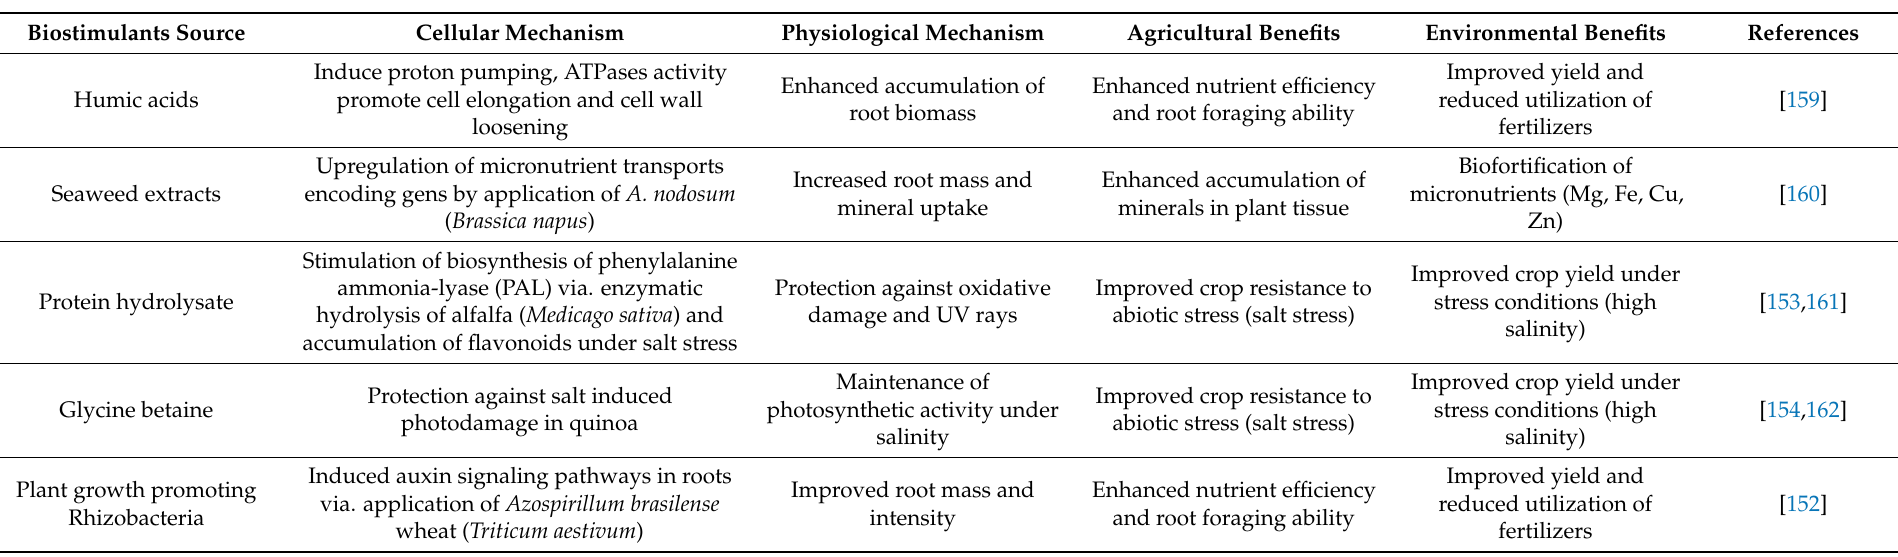
Table 4. Effects of different types of biostimulants on plant cellular and physiological mechanisms and their benefits for agriculture and environment